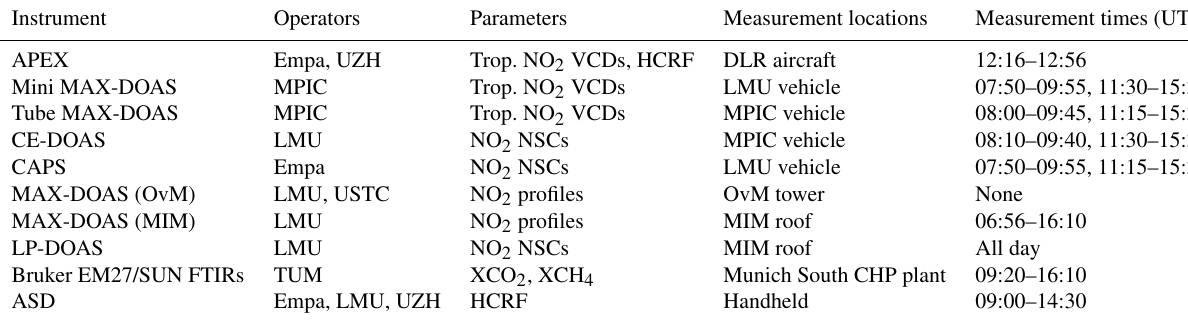
Table 1. Instruments and their measurements available during MuNIC on 7 July 2016. Instrument Operators Parameters Measurement locations APEX Empa,